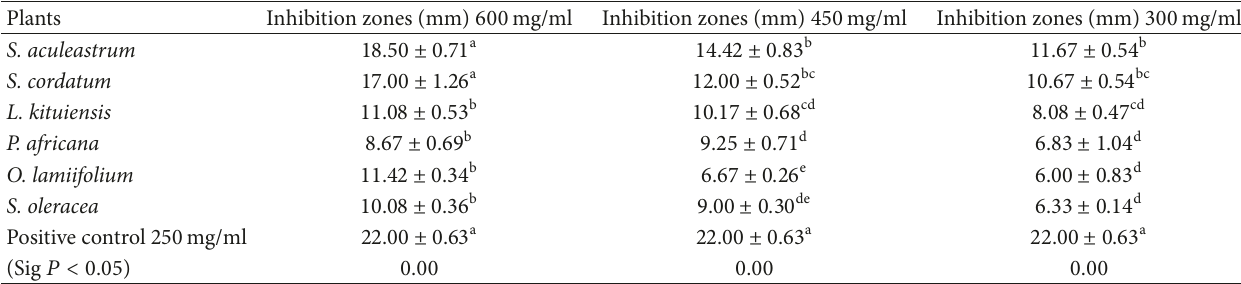
Table 2: Effect of different plant extracts against growth of A. flavus strain UONV017 at different concentrations.